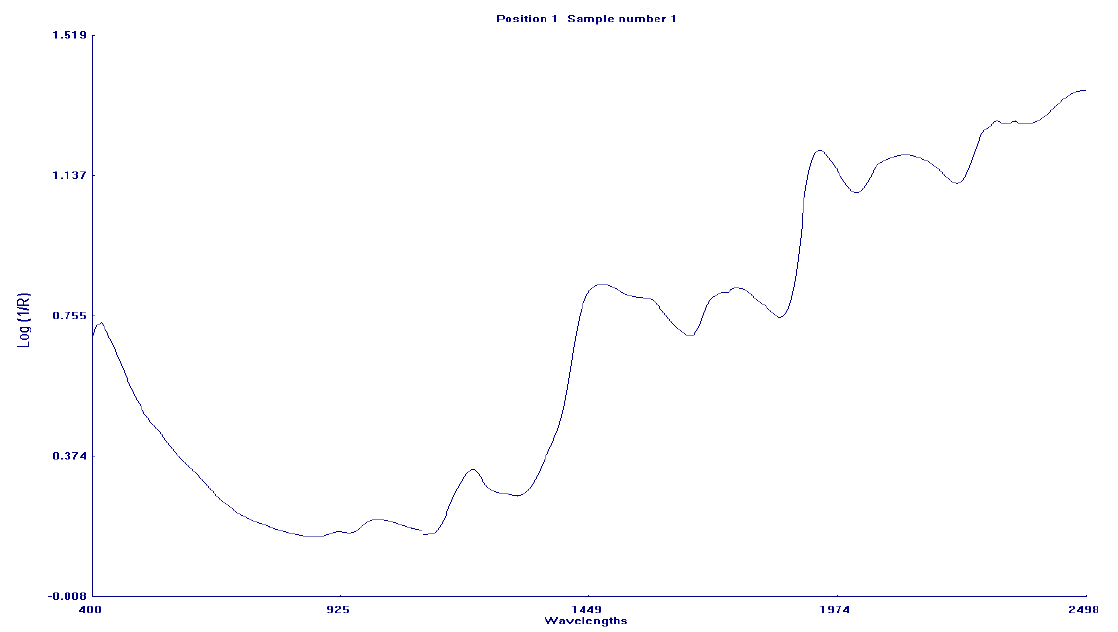
Figure 2. Average reflectance spectrum of amaranth and buckwheat homogenized flour with five absorption bands.